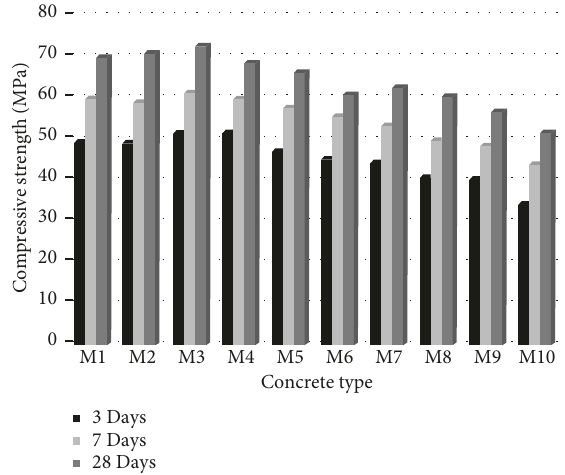
Figure 7: Compressive strength of SCC series at varying